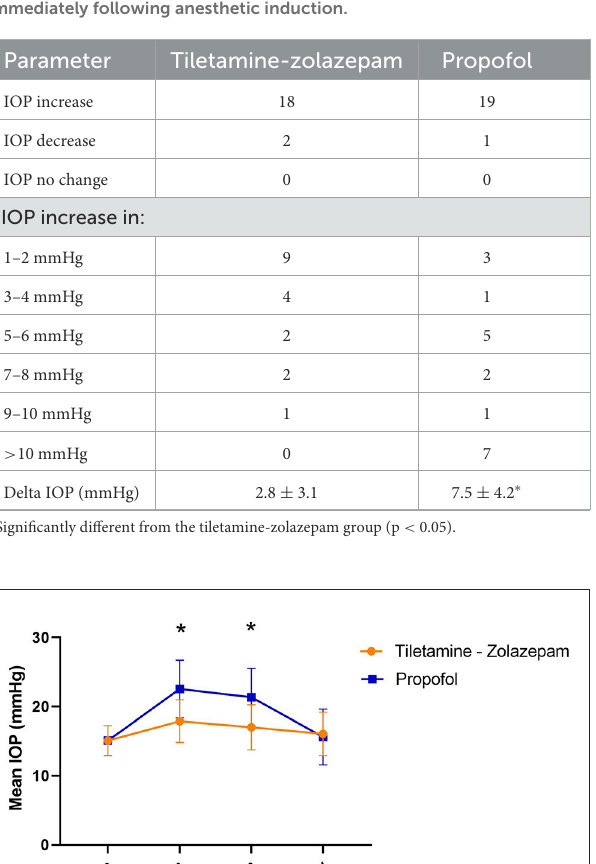
TABLE 2 Number of eyes that had an increase (and the extent to which it increased), decrease or no change following induction with tiletamine-zolazepam ( n = 20 dogs), or propofol ( n = 20 dogs) and mean ± SD of the delta in intraocular pressure between baseline and immediately following anesthetic induction.